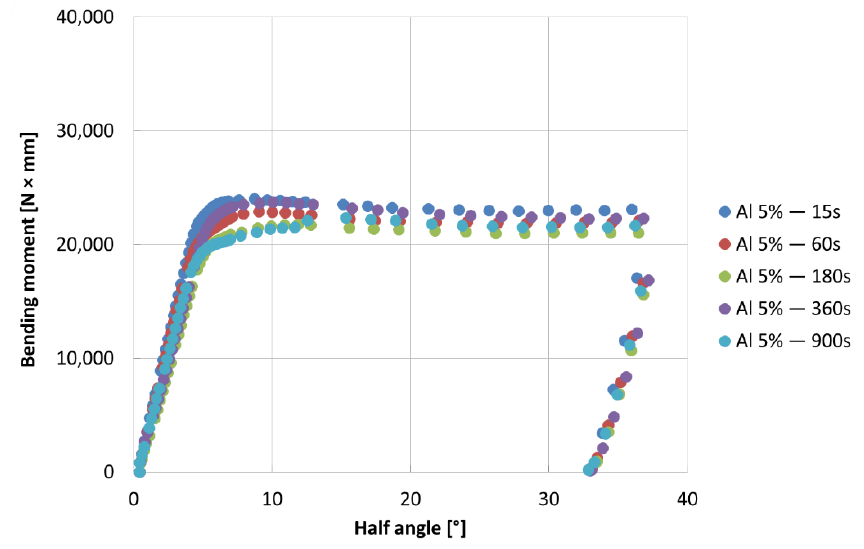
Figure 6. Bending tests results for specimens from Zn-Al 5% bath. After 15 s of immersion, the bending test results for all five coatings are shown in Figure 7. As can be observed, the greatest bending moment of the Zn-Sn 3% coating is at the maximum loading angle (30°). The same is true for the bending findings after 900 s of coating immersion, as shown in Figure 8, where the maximum bending moment is that of Zn-Sn 3%.